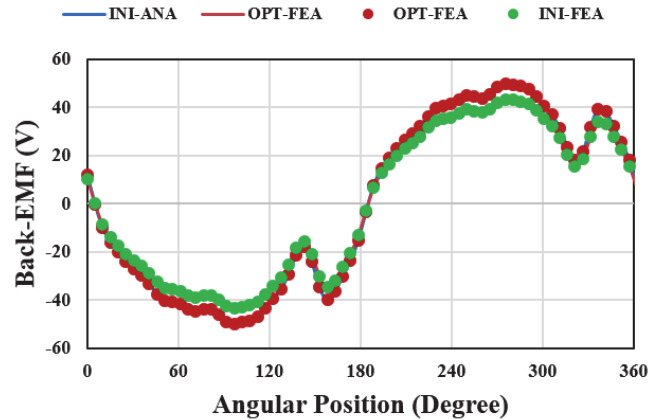
Figure 7. An on ‐ load analytical and numerical comparison of Back ‐ EMF.